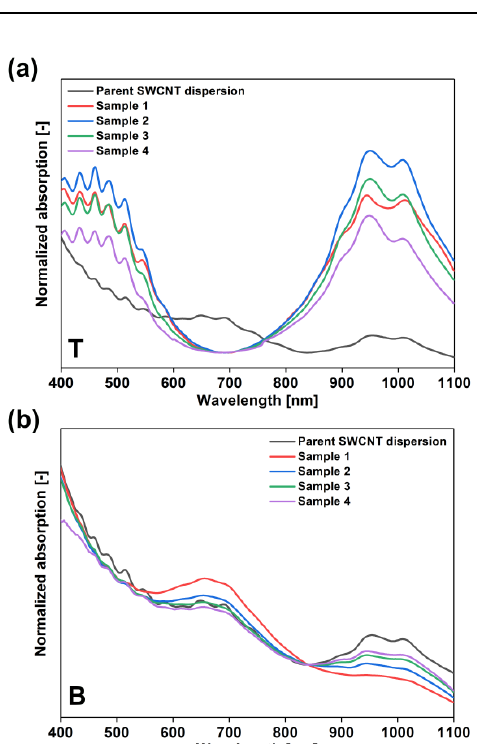
Figure 3. Absorption spectra of ( a ) top phases (PEG) and ( b ) bottom phases (DEX) of Samples 1–4 collected after ATPE separation at a fourfold higher concentration with varying contents of the H 2 O 2 modulator introduced at the expense of water. In both cases, the optical absorption spectrum of the parent dispersion is given as a reference.